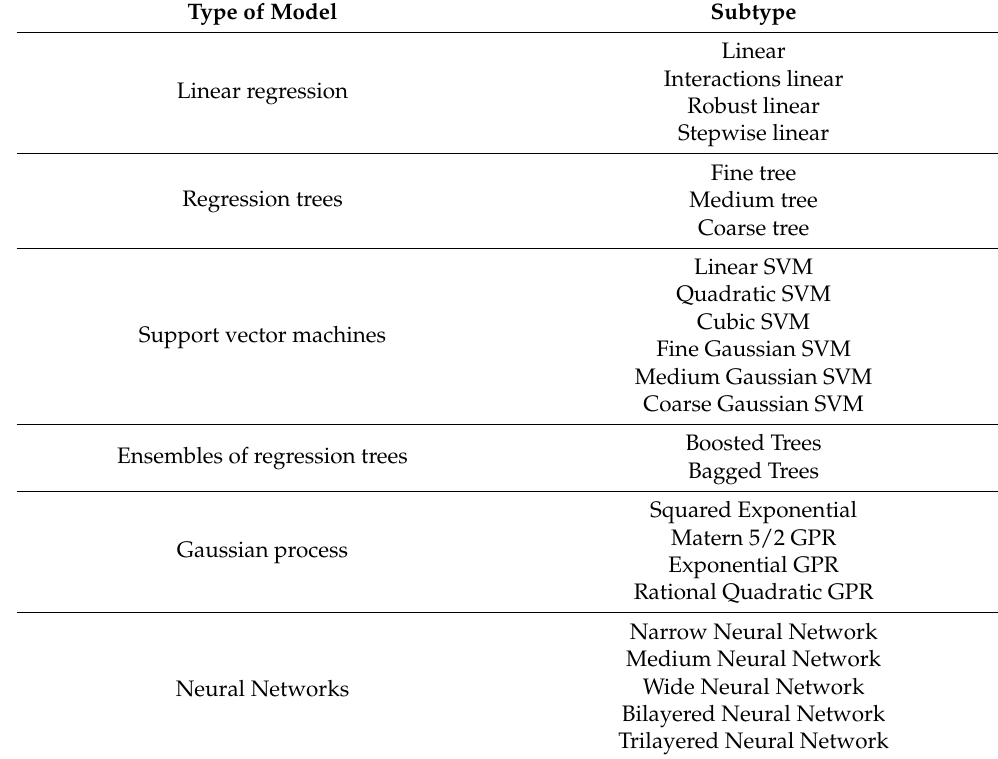
Table 3. Regression models tested.